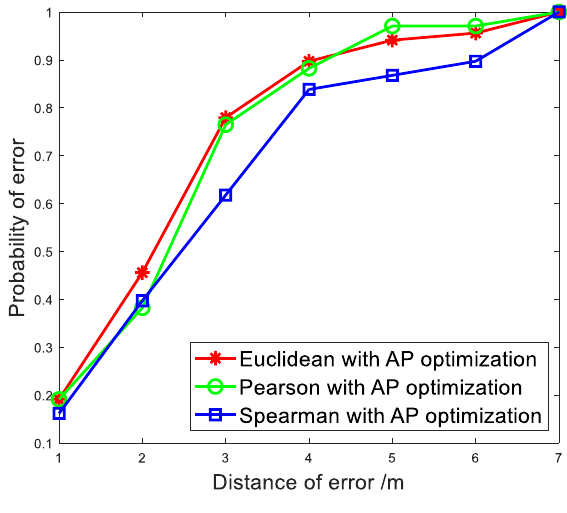
Figure 12. Probability of error.